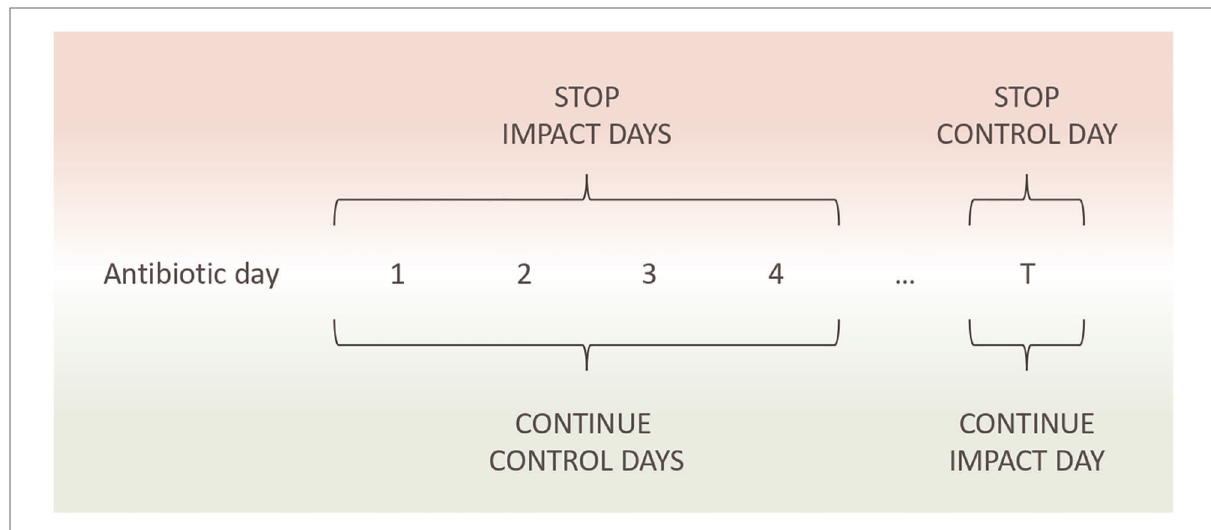
FIGURE 3 Demonstration of the impact and control evaluation process for stop and continue scenarios. An antibiotic day is de fi ned as each day the patient receives treatment as well as the day they stop. After starting antibiotics, each day the patient receives treatment acts as a stop impact and continue control. This continues until antibiotic cessation or ICU discharge. If the patient stops antibiotics during their ICU stay, that initial day where no antibiotics are administered acts as a stop control and a continue